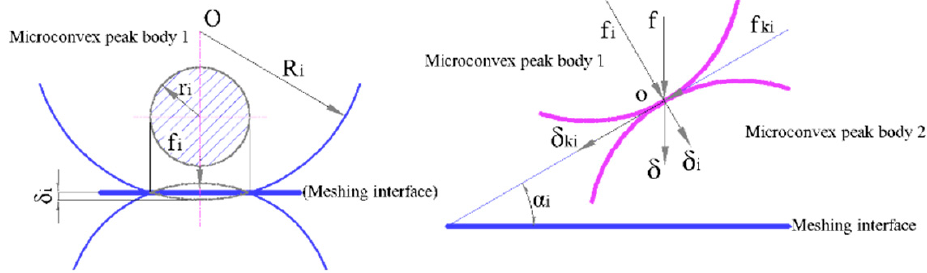
Figure 6. Schematic representation of geometric distribution of MGPs composite CIMT at the meshing point.